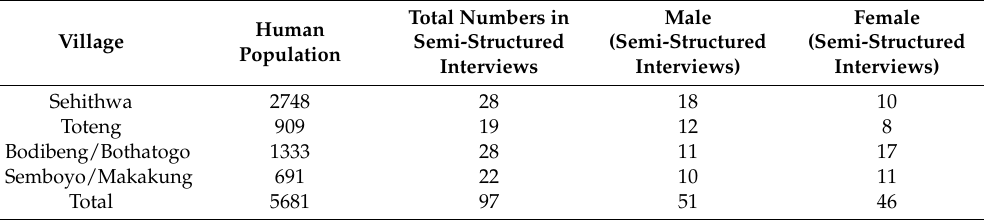
Table 1. Study villages and